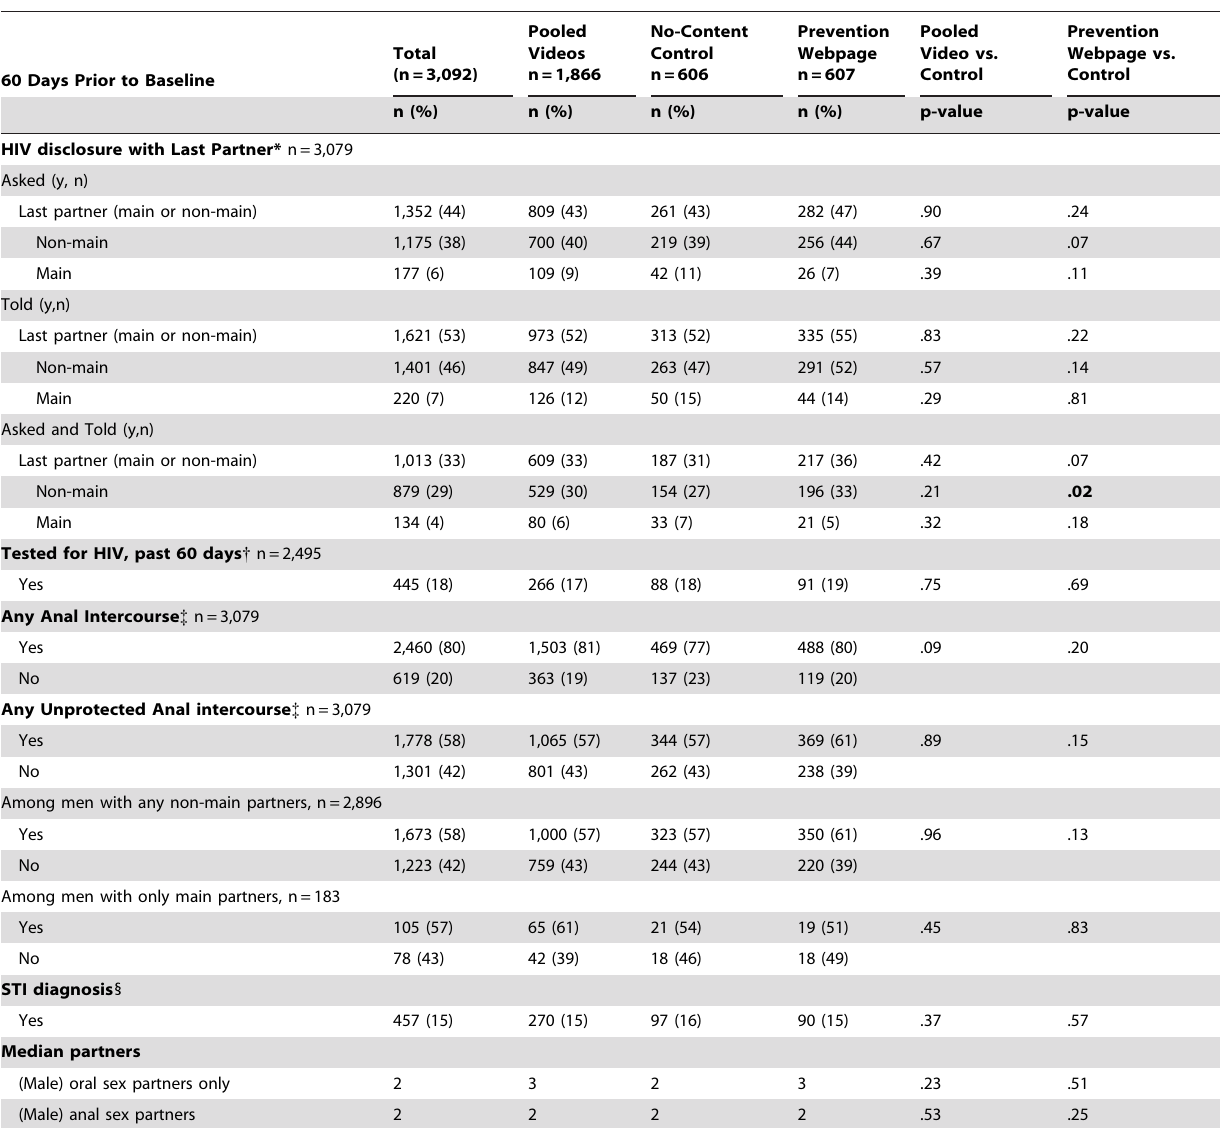
Table 2. Sexual Behavior in the 60 Days Prior to Enrollment by Randomization